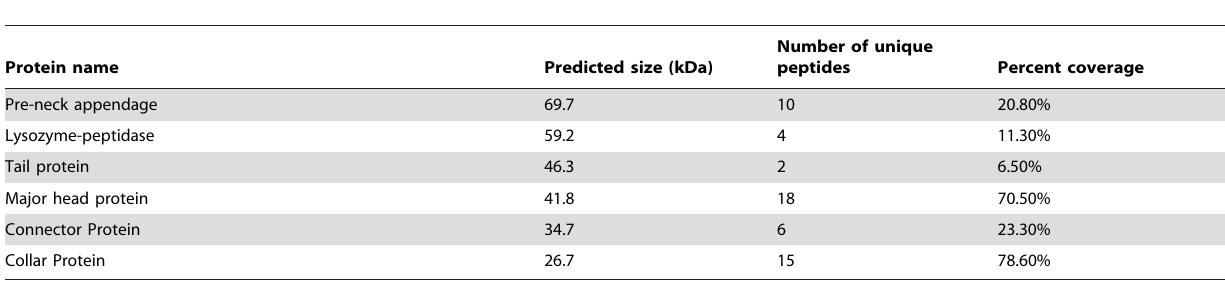
Table 1. Q CP7R Virion Proteomics Data Summary as Determined by Mass Spectrometry Analyses.